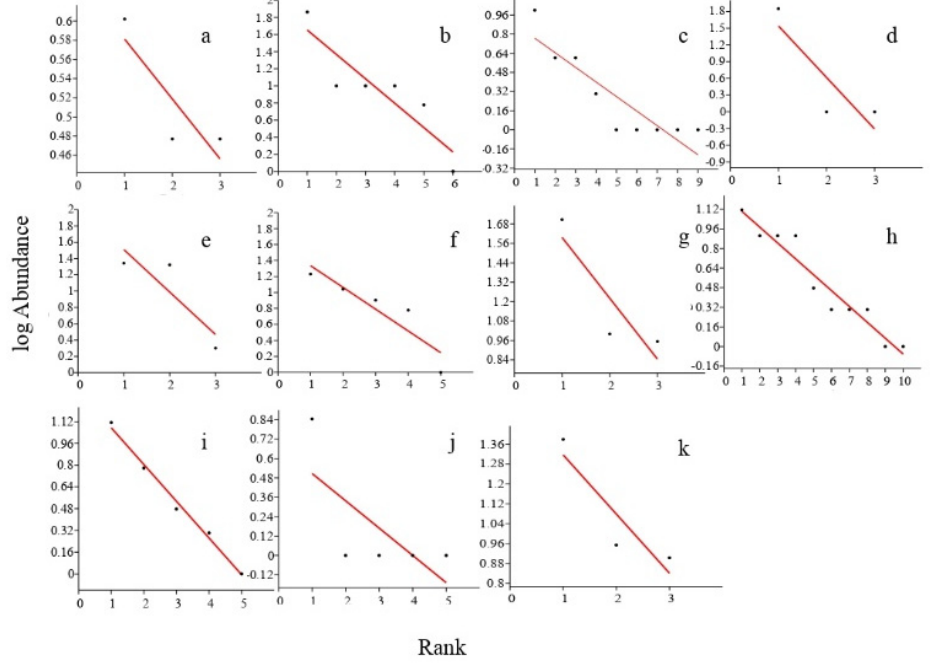
Figure 6. Preston’s rank abundance curve of endophytic bacterial communities at different growth stages of pearl millet. Rank abundance plots are based on relative abundance data when abundance was measured as cfu counts for each species. ( a ) 0 DAS ( b ) 14 DAS (Root) ( c ) 21 DAS (Root) ( d ) 28 DAS (Root) ( e ) 56 DAS (Above Shoot) ( f ) 63 DAS (Root) ( g ) 63 DAS (Below shoot) ( h ) 63 DAS (Middle shoot) ( i ) 63 DAS (Above shoot) ( j ) 70 DAS (Root) ( k ) 70 DAS (Above shoot). Abundance distribution of different ranked bacteria is shown by dots.